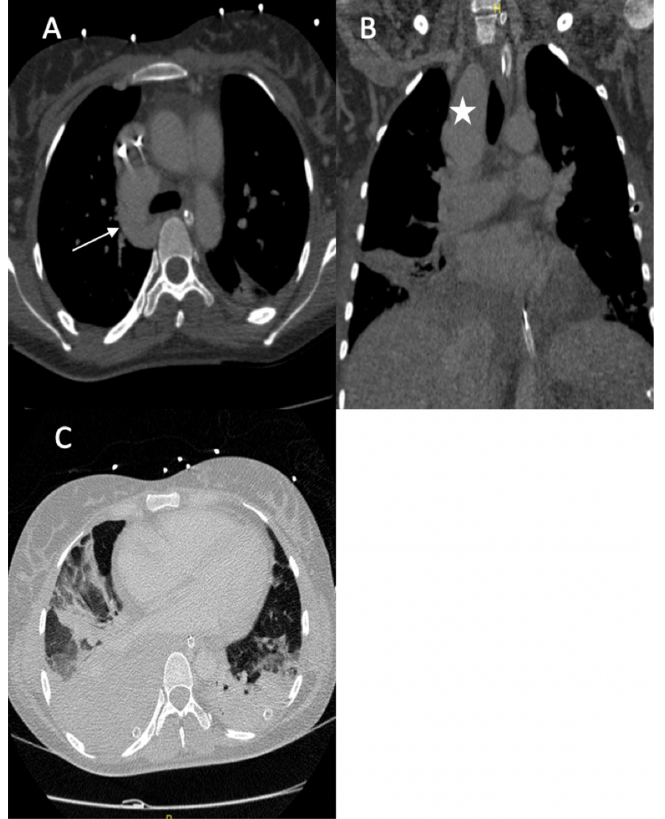
Figure 1. ( A ) Axial image from the contrast-enhanced thoracic CT scan revealed an arteriovenous fistula between the apical segmental artery and the azygos vein (arrow); ( B ) coronal section of the CT scan revealed a pseudoaneurysm of the right lobe superior artery (star); ( C ) axial image thoracic CT scan (pulmonary window) showed bilateral pleural effusions with ground glass opacity, most likely due to pulmonary